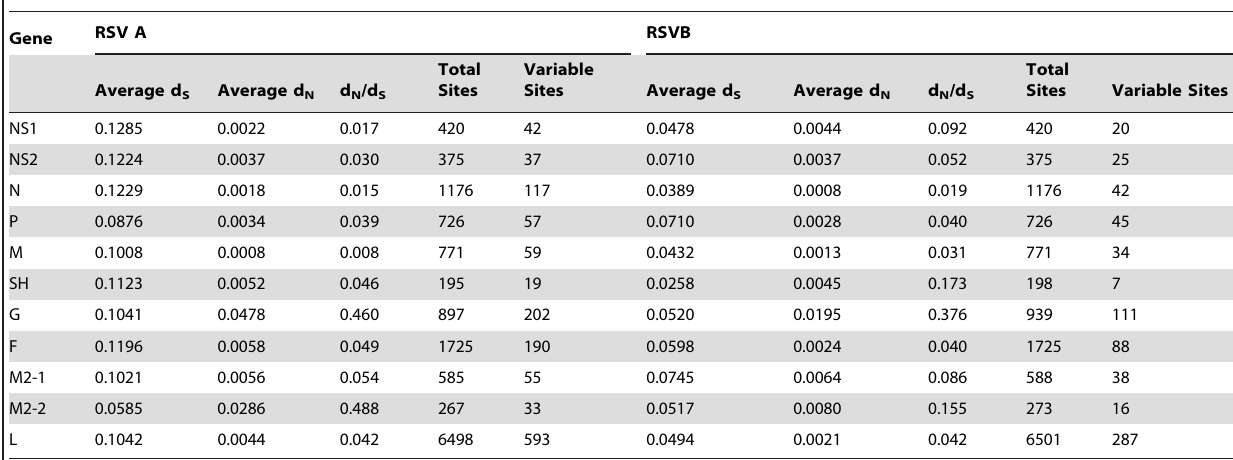
Table 2. Variation of each coding sequence in RSV A and B.